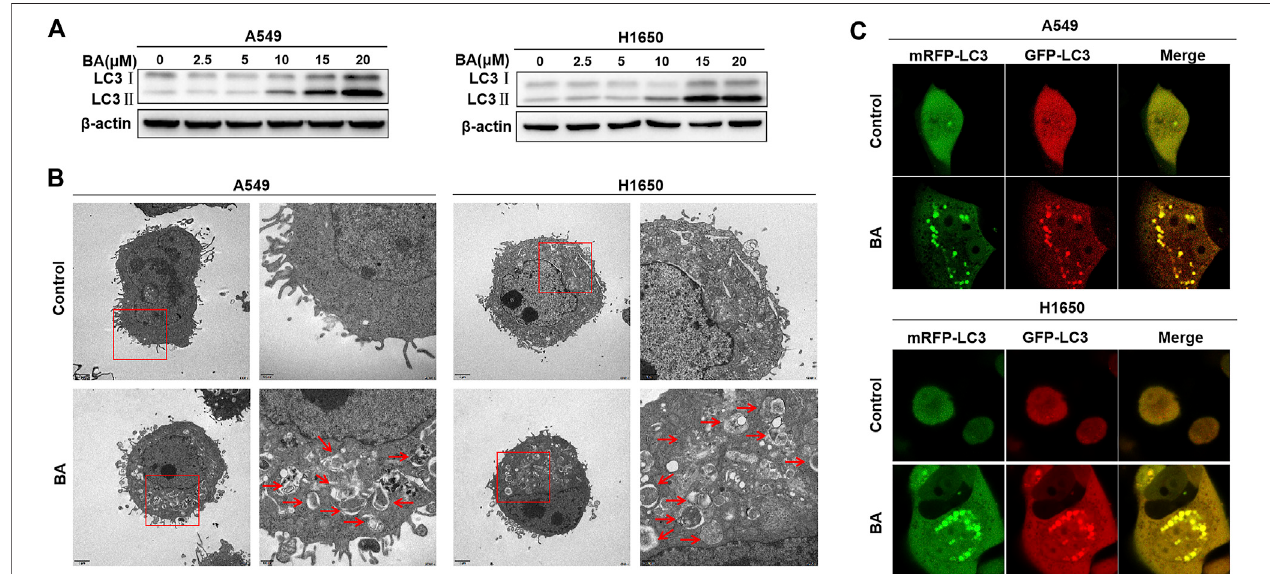
FIGURE2| BA induces autophagy inNSCLC cells. (A) A549and H1650 cells were treatedwith theindicatedconcentrations ofBA for48 h, and the expression of autophagy-related protein LC3 was analyzed by Western blots. (B) A549 and H1650 cells were treated with 15 μ M BA for 48 h, and the autophagic vacuoles were observedusingtransmissionelectronmicroscopy. (C) A549andH1650cellsweretransfectedwithadenovirusexpressingmRFP-GFP-LC3,thentreatedwith15 μ MBA for 48 h, and representative images were obtained using a confocal